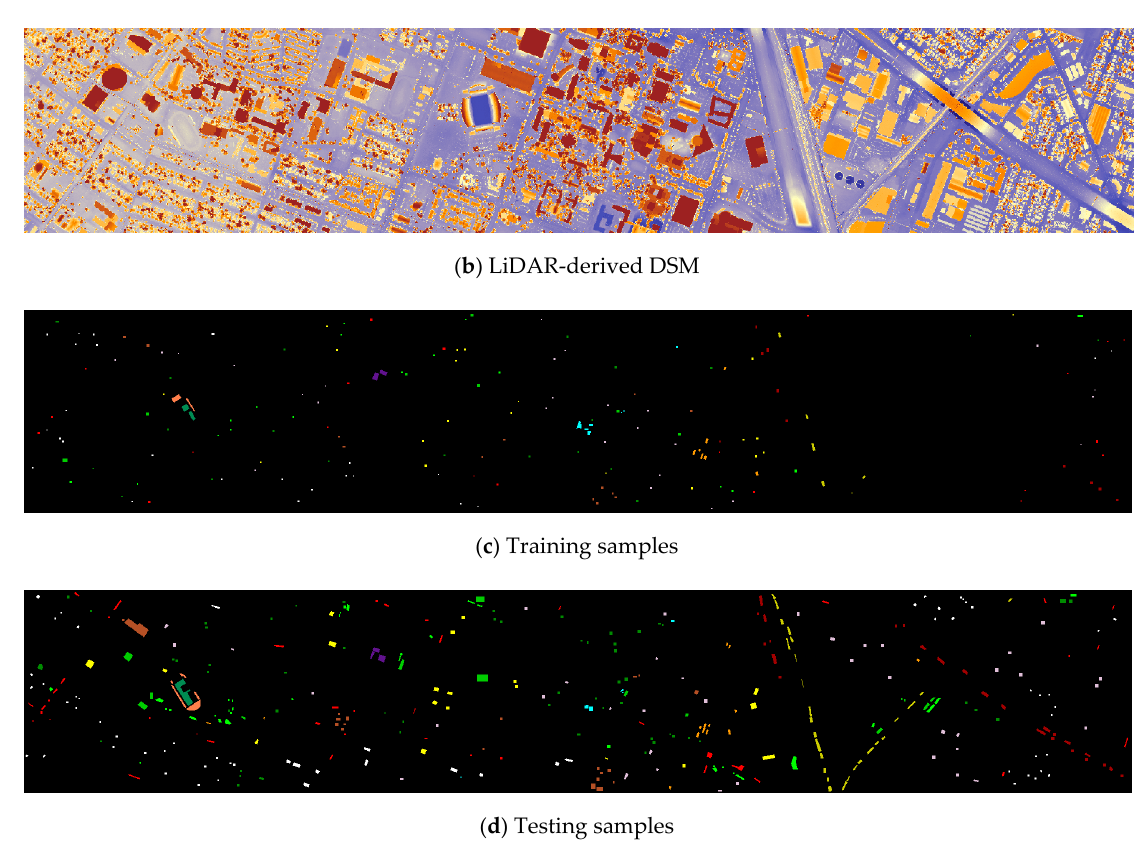
Figure 1. Datasets, training, and testing samples used in this study.